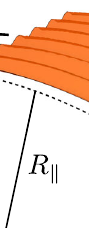
FIG. 2. Schematic of a wrinkled rectangular patch, showing σ k and R k . Their values and the total length of the buckled region, l k , are quantified in Table I for each